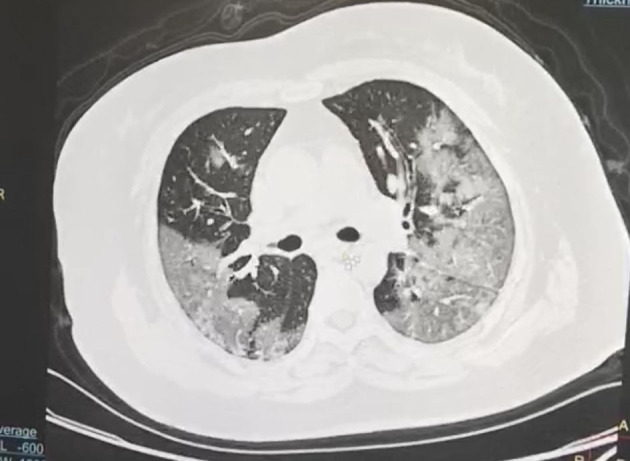
Diffuse ground-glass opacity in both lungs accompanied by air bronchogram.